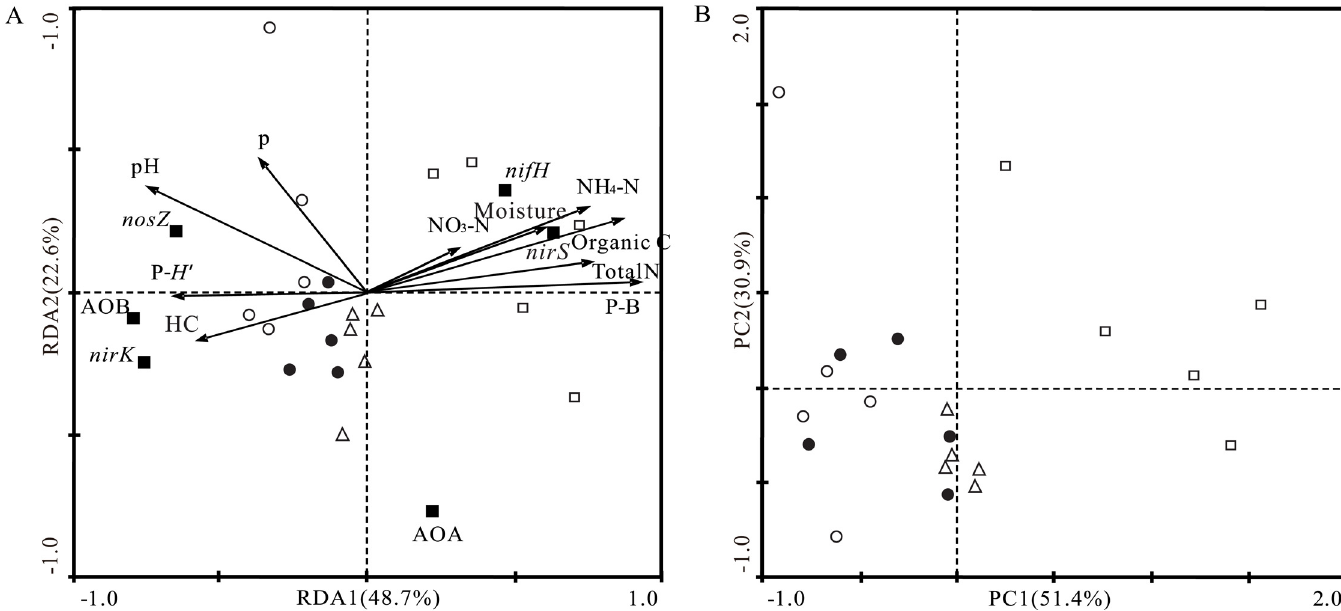
Fig 3. Relationships between nitrogen-cycle gene abundance and environmental variables based on redundancy analysis (A) and distribution of nitrogen-cycle gene abundance based on principle component analysis (B). Each site contained five replicates of a randomized plot (1 × 1 m) design as follows: cropland abandoned for 2 years, or Y2 (site 1, ● ); cropland abandoned for 6 years, or Y6 (site 2, ○ ); cropland abandoned for 26 years, or Y26 (site 3, 4 ); and the control light-grazing steppe grassland, or LGSG (site 4, □ ). Nitrogen-cycle genes are indicated by closed squares ( & ) and environmental variables are indicated by